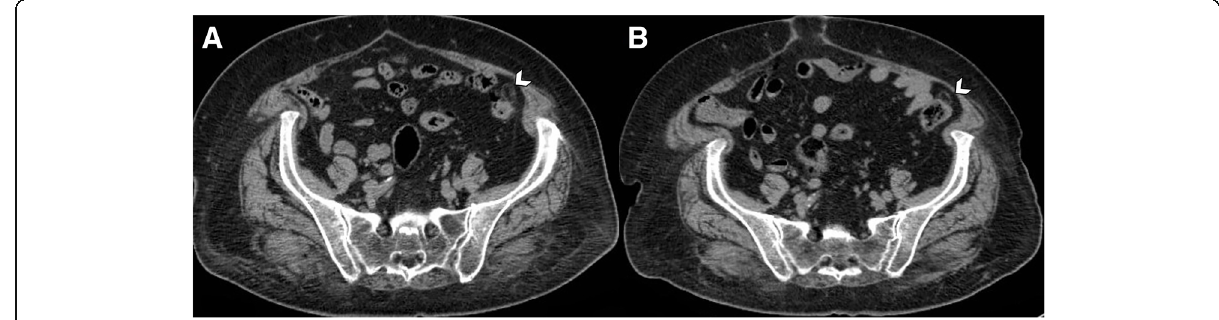
Fig. 6 Evolution of acute epiploic appendagitis in a 72-year-old woman. a Axial non-contrast CT image shows a pericolonic fat-density lesion (arrowhead) that abuts anteriorly the colon-sigmoid junction in the left iliac fossa. b At 3-month follow-up, CT image demonstrates reduction in size of the lesion (arrowhead)